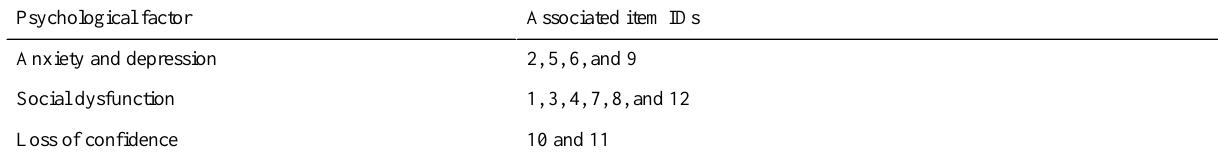
Table 2. Associations between items and psychological factors of the 12-item General Health Questionnaire.